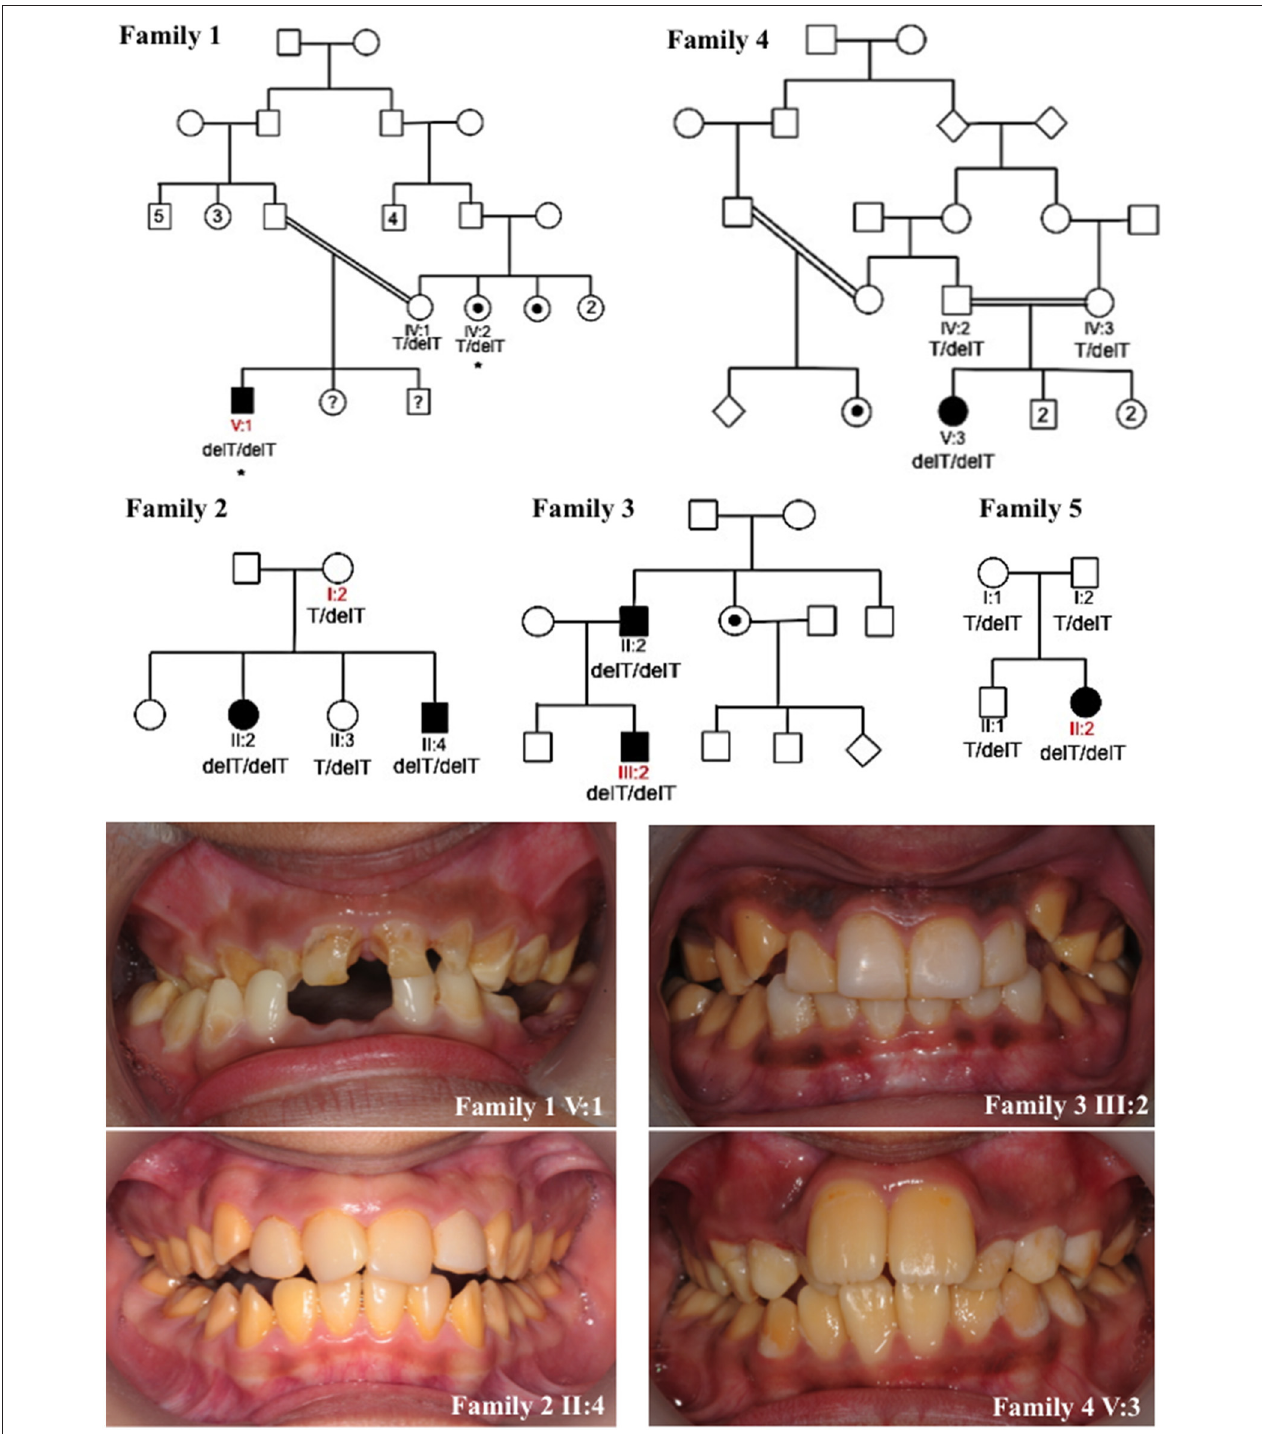
FIGURE 1 | Pedigrees and clinical images of families 1–5. Red labels indicate the individuals for which DNA was subjected to whole exome sequencing for families 1–3 and 5. Asterisks mark individuals in family 1 whose DNA underwent SNP genotyping analysis. Dots indicate individuals that self-reported as affected with AI or were reported by other family members to be affected with AI. However these individuals were not themselves clinically assessed by a dental practitioner. Question marks indicate individuals for which details of their AI phenotype were unavailable. The genotypes of the KLK4 c.632delT variant (NM_004917.4) for each individual for which DNA was available for analysis are marked on each pedigree. Clinical images show hypomaturation AI in families 1–4. Clinical images were unavailable for family 5.